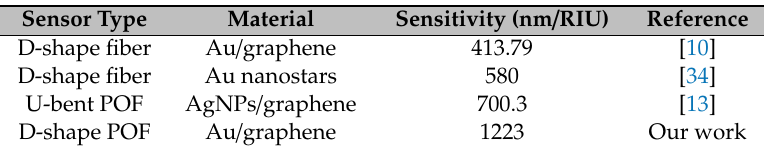
Figure 4. ( a ) Normalized transmission spectrum of Au-graphene structure D-type fiber sensor in alcohol solutions at di ff erent concentrations. ( b ) The normalized transmission spectrum of D-type fiber sensor with only a gold film structure in alcohol solution at di ff erent concentrations. Table 1. Comparison of sensitivity with other fiber optic sensors.